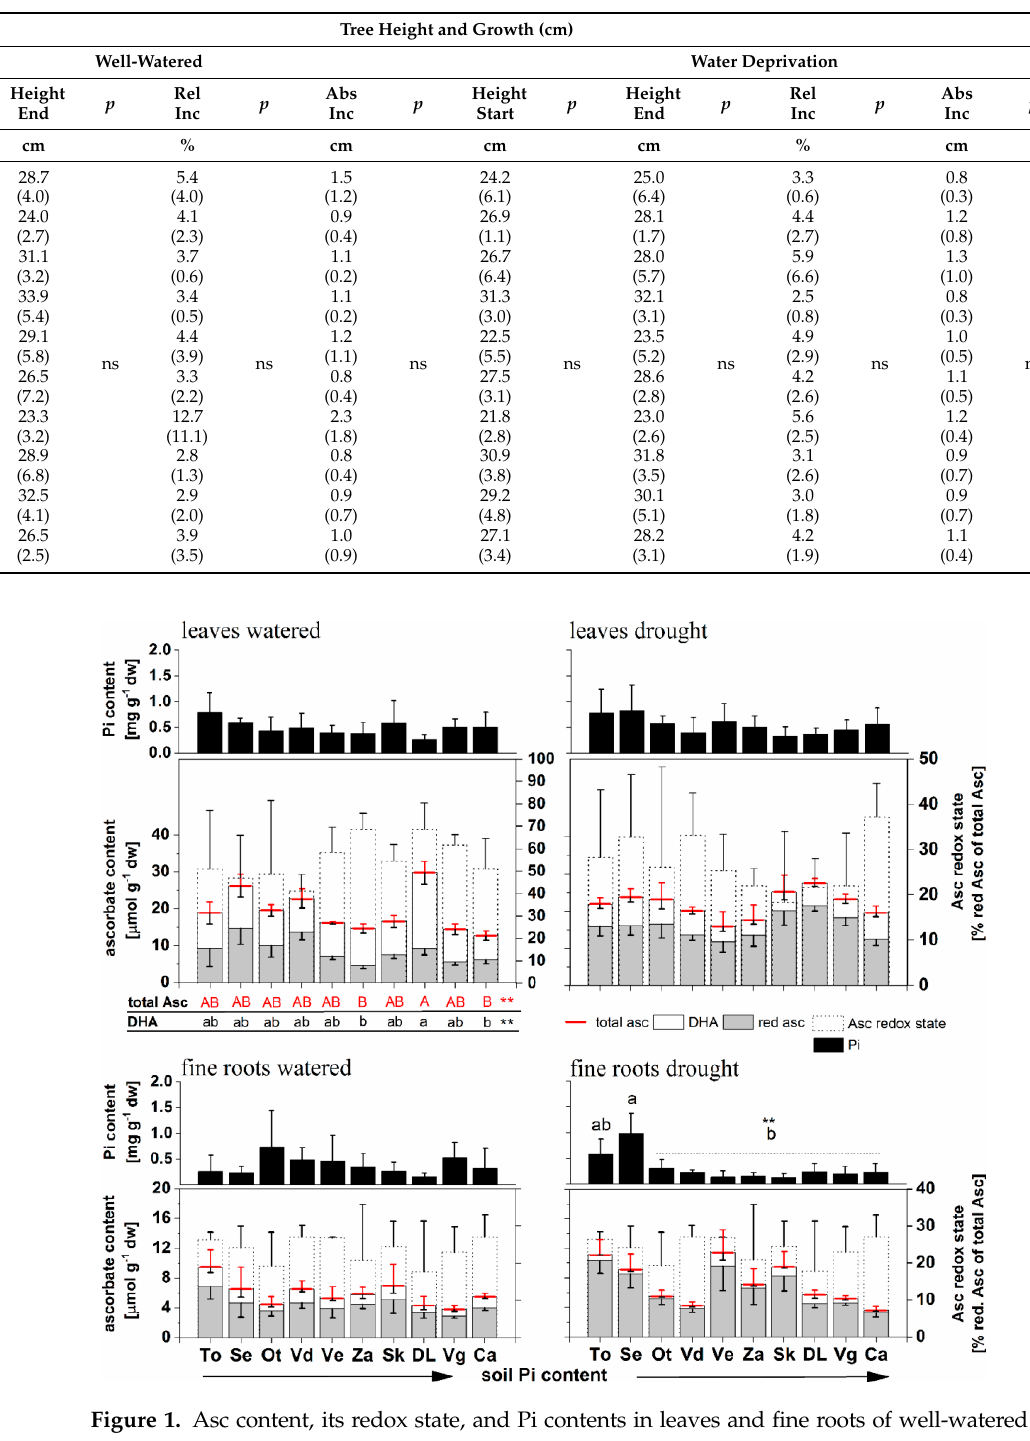
Table 4. Tree heights and absolute and relative height increases of beech saplings. The mean values + S.D.s of five replicates in the well-watered control (2nd harvest) and in the drought treatment are shown. Height start = tree height prior to the onset of 29 day of water deprivation, height end = tree height after 29 days of water deprivation. p = results of one-way ANOVA in the well-watered or the drought treatment between the sites ( p < 0.01) . Different minor letters represent statistically significant differences between the ecotypes at p < 0.01. Beech ecotypes are organized according to decreasing total Pi.